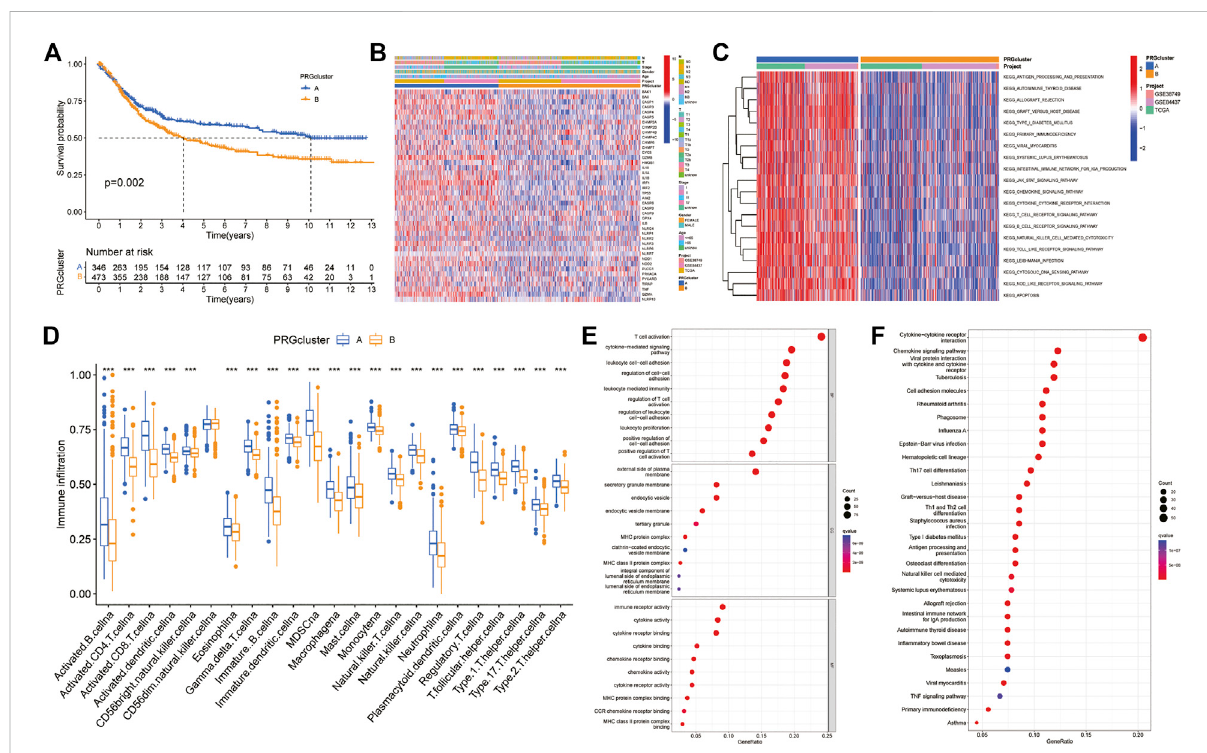
FIGURE 3 Difference analysis between two PRG-related subtypes (A) Kaplan-Meier survival curves between the two subtypes (B) Differences in clinical characteristics in distinct subtypes (C) GSVA enrichment analysis (D) Differences in immune cell in fi ltration between the two subtypes (E,F) GO and KEGG enrichment analyses of pyroptosis-related DEGs. DEGs: differentially expressed genes. GO: Gene Ontology. KEGG: Kyoto Encyclopedia of Genes and